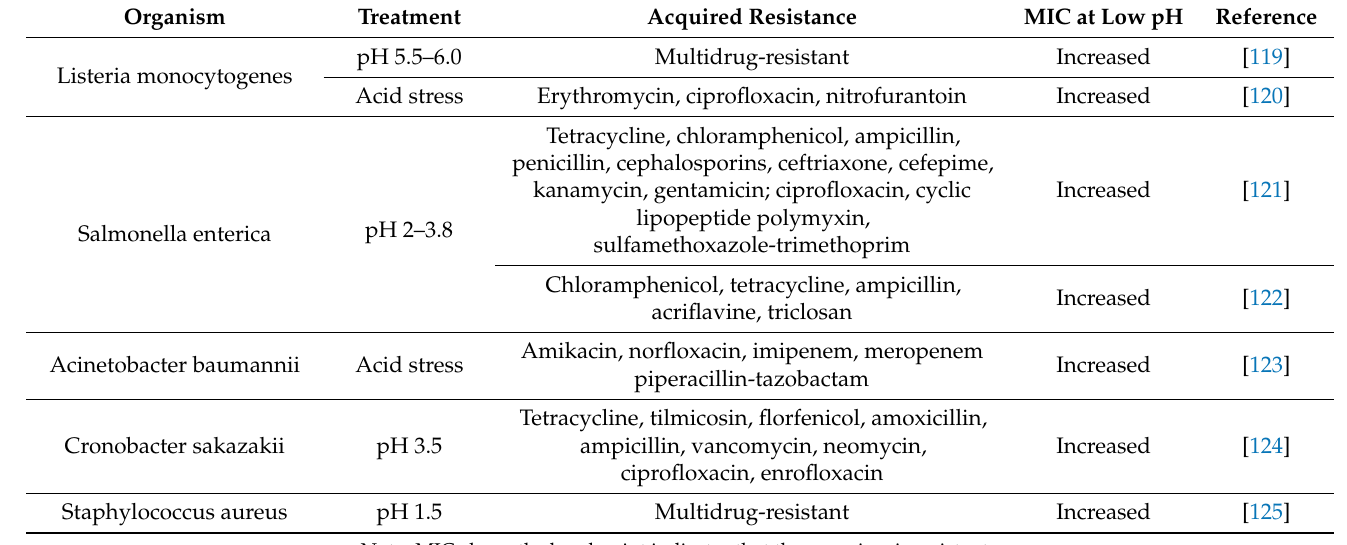
Table 2. Acid-adapted pathogens other than EHEC pathotypes’ and their acquired antibiotic